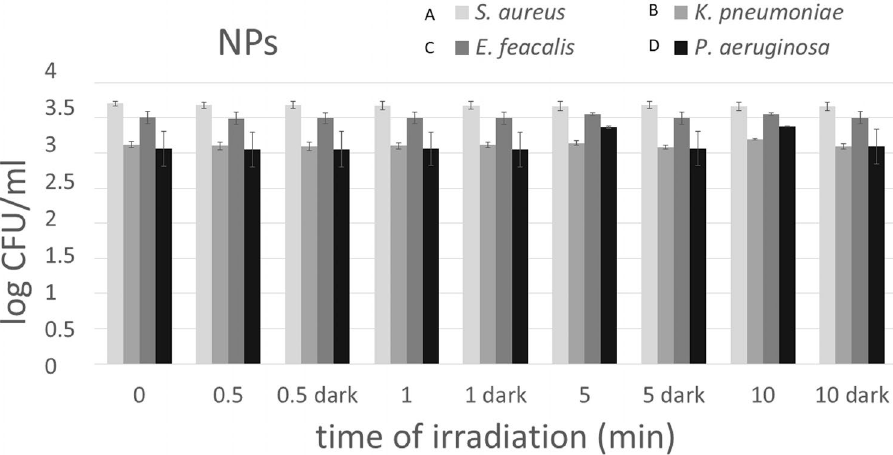
Figure 1. Photoinduced antibacterial activity of the polystyrene NPs (1.5 × 10 12 NPs/ml) at different dose of irradiation. NPs dispersions (3 × 10 12 NPs/ml) were mixed 1:1 with a dispersion of MRSA- S. aureus ( A ), ESBL- K. pneumoniae ( B ), E. faecalis ( C ) and P. aeruginosa ( D ). The results show the estimated average logarithm of the colony forming units per ml (log CFU/ml) observed on the agar plates for the irradiated and non-irradiated samples from 3 independent tests at room temperature.